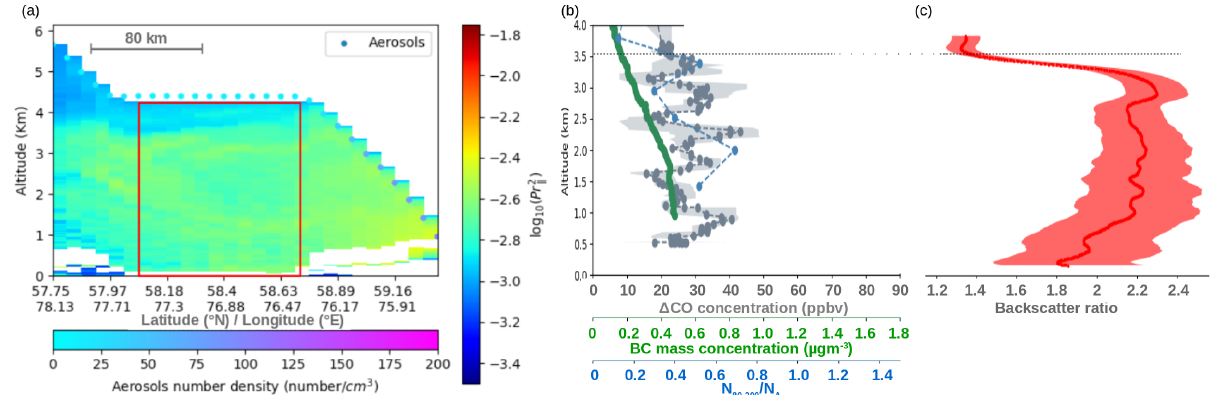
( PR 2 ) on 18 June 2017 at 01 UT. Calibration constant is 63413 ± 2%. Figure 7. ( a ) Vertical cross-section of airborne lidar log 10 Grimm aerosol concentrations in particle.cm − 3 are shown at the aircraft altitude. ( b ) Vertical profiles of ∆ CO in ppbv (grey), BC in µ g.m − 3 (green) and ratio of N 80 − 200 /N A (blue dashed line) concentrations for the descent at 59 ◦ N. ( c ) Backscatter ratio vertical profile for the lidar data in the red box. The horizontal dotted line is the top of the aerosol layer according to the lidar data.